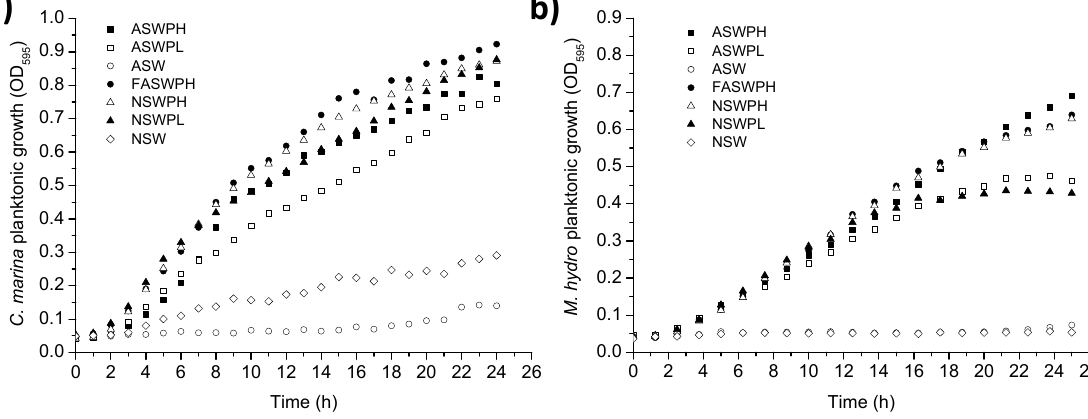
Figure 1. Bacterial growth kinetics over 24 h under different media, using optical density at λ = nm (OD ), where: ( a ) Cobetia marina and 595 ( b ) Marinobacter hydrocarbonoclasticus . ASWPH, artificial sea water peptone high; ASWPL, artificial sea water peptone low; ASW, artificial sea water; FASWPH, filtered artificial sea water peptone high; NSWPH, natural sea water peptone high; NSWPL, natural sea water peptone low; and NSW, natural sea